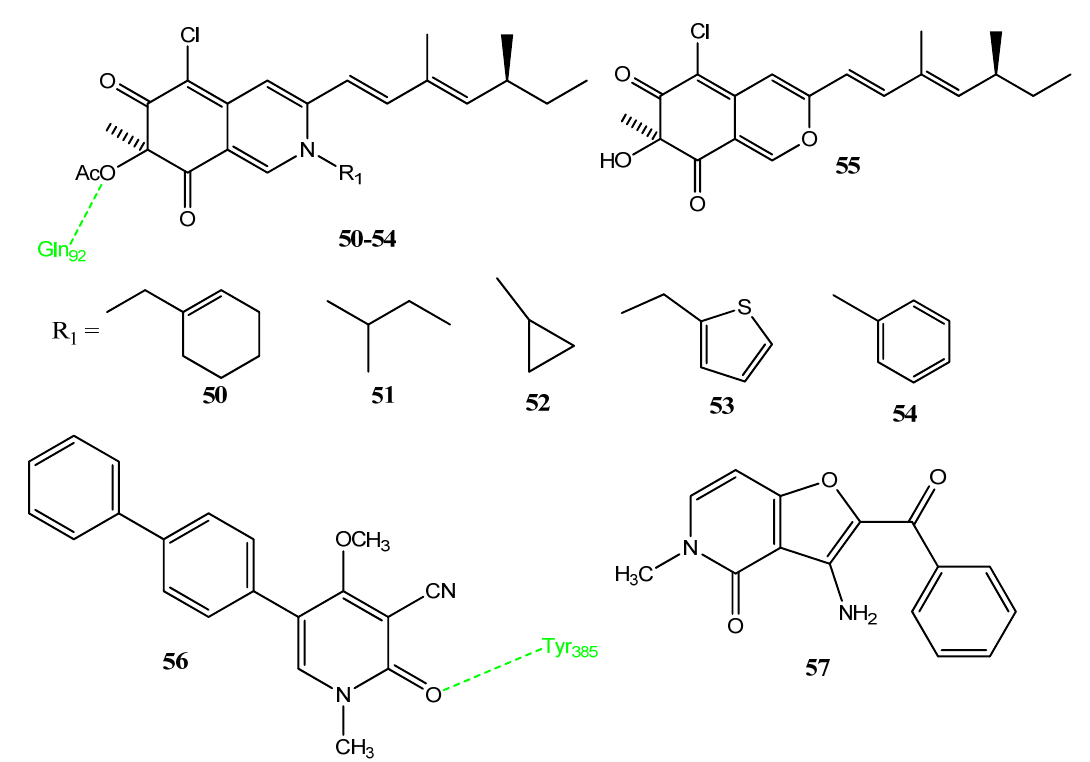
Figure 11. Derivatives of sclerotiorin and ricinin.